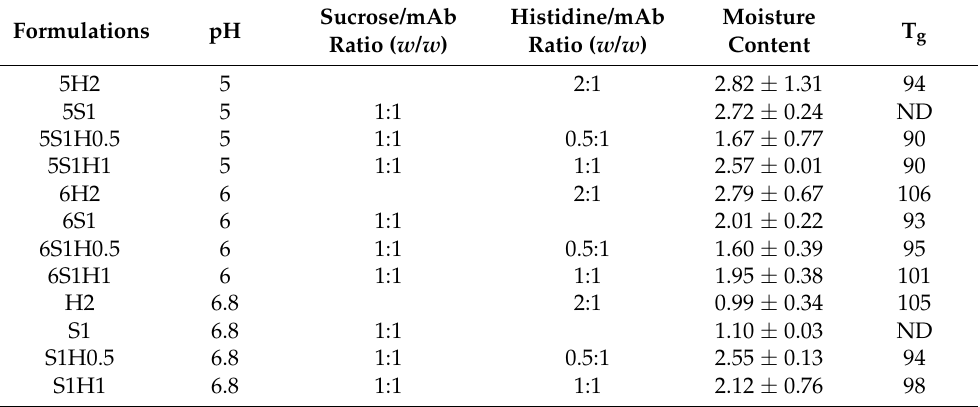
Table 2. The effect of sucrose and histidine as excipients on T g is presented in the table. The moisture content was measured by Karl Fischer titration